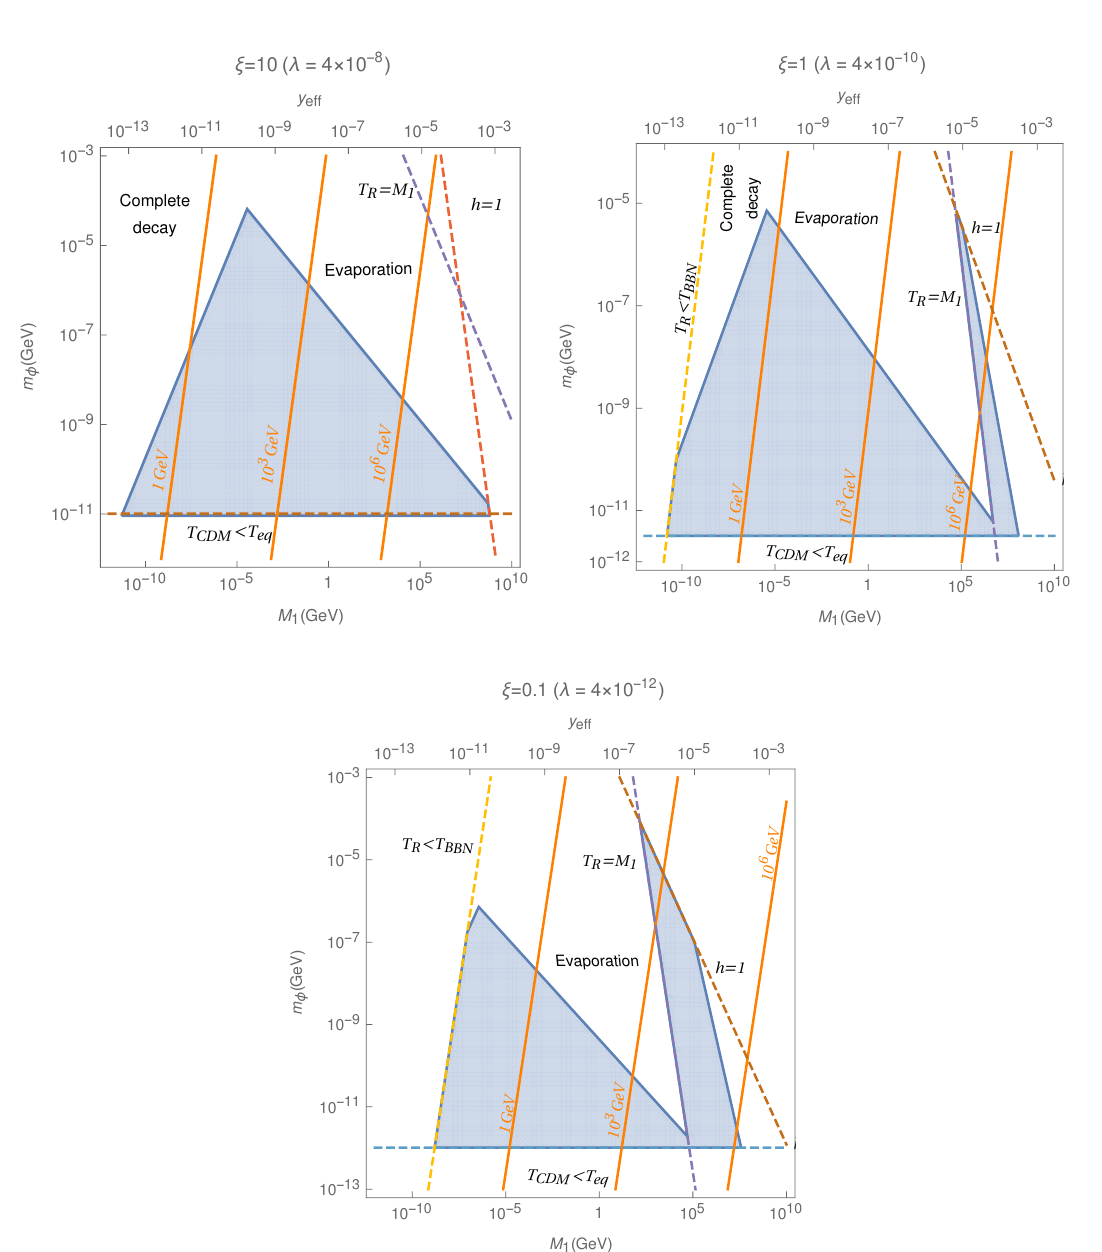
Figure 6 . Constraints on model parameters for (cid:24) = 0 : 1 ; 1, and 10, taking g ? = 100. The shaded blue regions correspond to parameter values satisfying all constraints in the oscillating scalar (cid:12)eld dark matter scenario. Orange lines represent di(cid:11)erent values for the reheating temperature and the blue dashed line, M 1 = T R , limits the evaporation conditions. The h = 1, T R < T BBN and T CDM < T eq limits are also represented by dashed lines. The condition (4.54) de(cid:12)nes the \complete decay" and \no reheating" regions and conditions (4.55) and (4.56) limit the \evaporation" region.